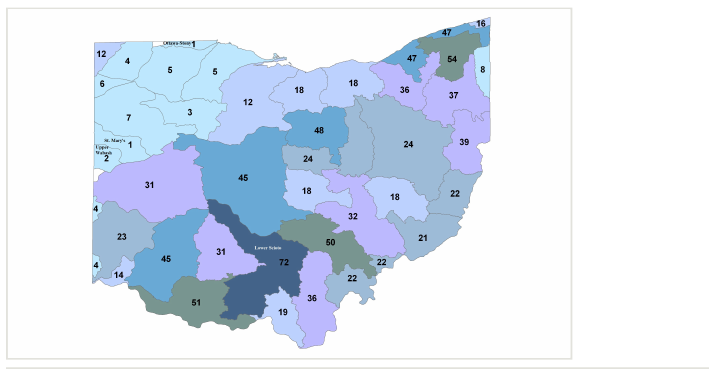
Figure 2. Stone fl y species richness for 41 Ohio USGS HUC8 watersheds. Watershed color coded by similar richness. Watershed names for some species poor and species rich drainages provided.